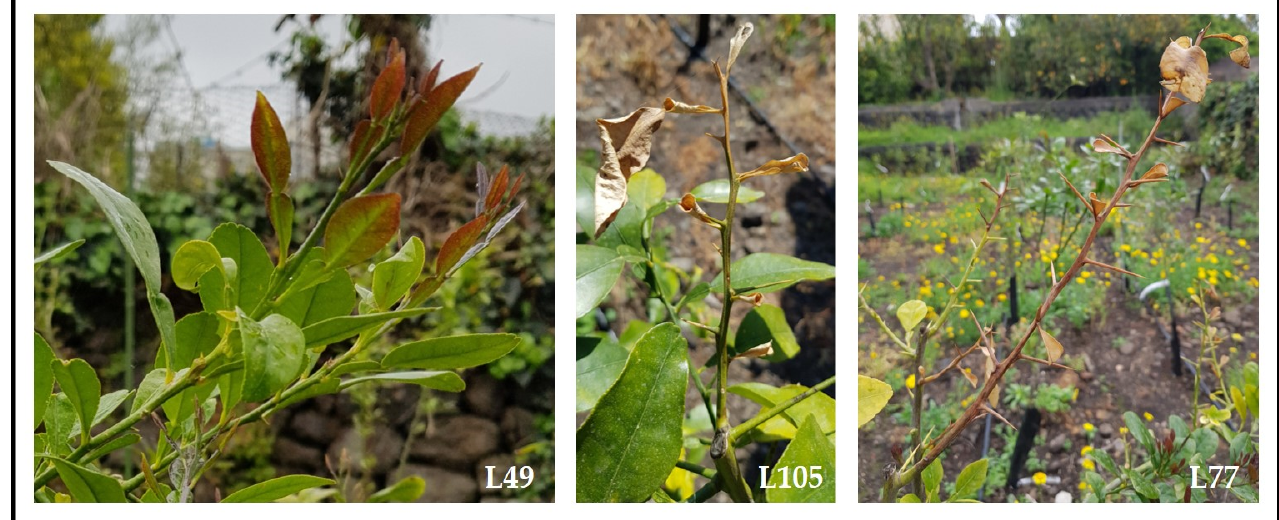
Figure 5. Mal secco symptoms on different C. latipes × ‘Femminello Siracusano 2kr’ lemon hybrids cultivated in an area where pathogen pressure is naturally high. From left to right: hybrid L49 does not show any symptom, hybrid L105 is at the initial phase of stem desiccation, while hybrid L77 shows complete twig dieback.